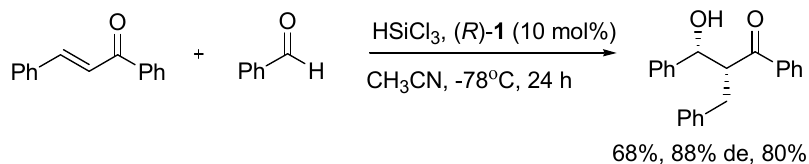
Molecules 2019 , 24 , x